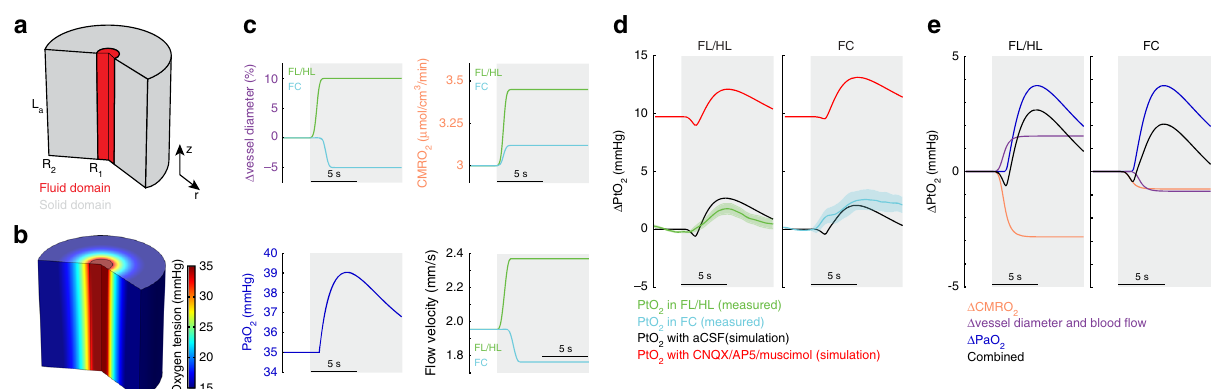
Fig. 5 Tissue oxygenation during locomotion depends on the interplay of arterial oxygenation, CMRO 2 and vasodilation. a Schematic showing the model geometry and boundary conditions. The 2D axisymmetric model consists of two domains, the fl uid (or blood) domain, and the solid (or tissue) domain. The axial (z) length of both the domains is L a . The fl uid domain has an outer radius of R 1 and the solid domain has an outer radius of R 2 . A pressure difference across the length of the blood vessel and an imposed vasodilation pro fi le are used to change the vessel diameter and the fl uid velocity simultaneously. The arterial oxygen concentration is imposed as a boundary condition at the vessel inlet. b The oxygen tension in the blood vessel and surrounding tissue under rest (stationary) conditions. c Simulated locomotion-induced changes in vessel diameters in FL/HL and FC (top left), cerebral metabolic rate of oxygen consumption (CMRO 2 ) in FL/HL and FC (top right), blood fl ow velocity at the centerline of the vessel (bottom left), and arteriole oxygen tension (PaO 2 , bottom right). d Simulated effects of inhibiting neural activity using CNQX/AP5/muscimol on locomotion-evoked PtO 2 change ( Δ PtO 2 ) in both FL/HL (left) and FC (right). Green and cyan shaded area denote one SEM of measured PtO 2 change in FL/HL and FC, respectively. e Decomposition of locomotion-evoked oxygen changes in FL/HL (left) and FC (right). In both regions, changes in arterial oxygenation strongly in fl uence tissue